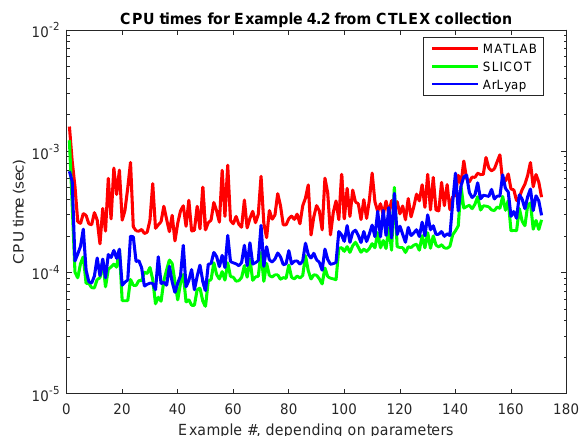
Figure 5. Elapsed CPU time for CTLEX 4.2 series of examples.